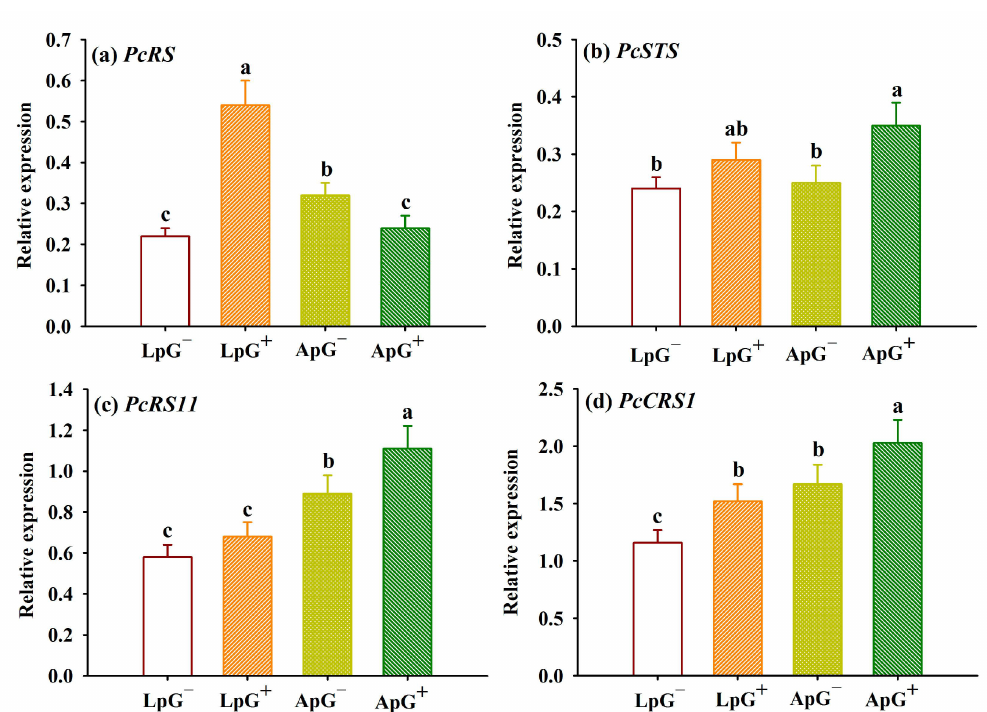
Figure 7. Changes in expressions of leaf PcRS ( a ), PcSTS ( b ), PcRS11 ( c ), and PcCRS1 ( d ) of Polygonum cuspidatum inoculated with Glomus mosseae in low and approximate P levels. Different letters on the bars indicate significant ( p < 0.05) differences between treatments. See Figure 1 for